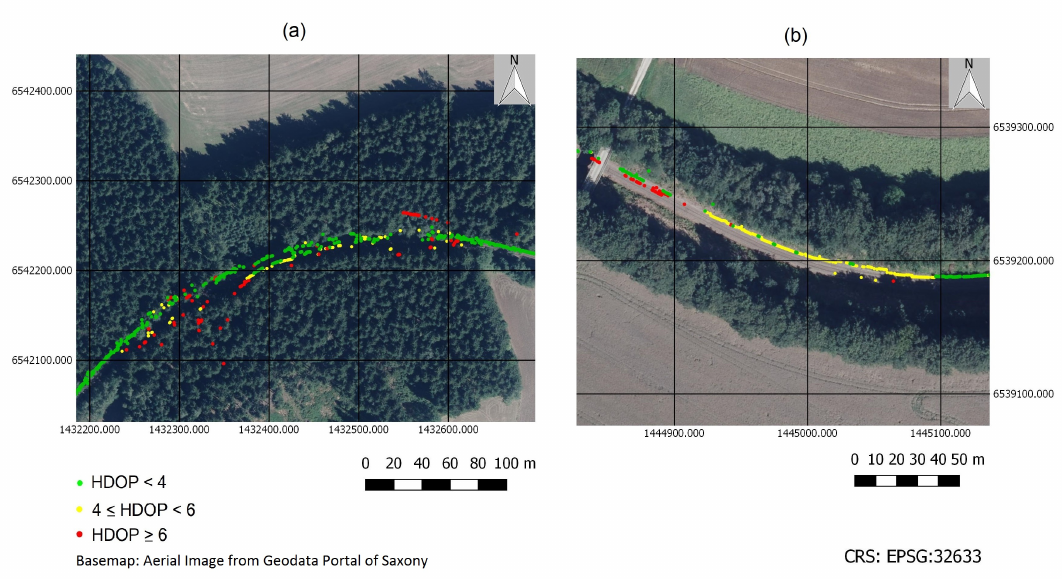
Figure A1. ( a ) A section covered by trees ( b ) A section where too many points were discarded by the rule HDOP < 4.